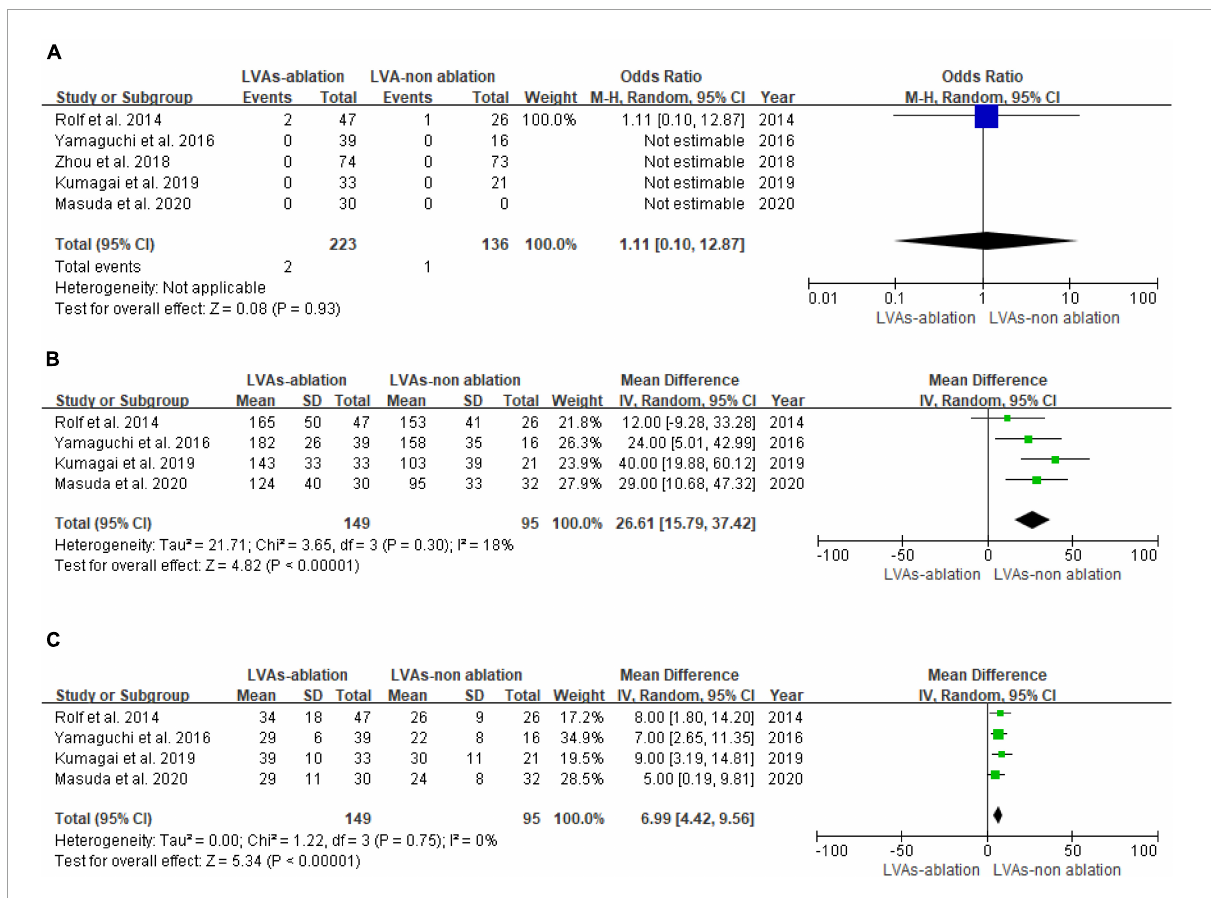
FIGURE4 Forest plot of procedural data. (A) Complication of LVAs patients with or without LVAs substrate modification. (B) Procedure time of LVAs patients with or without LVAs substrate modification. (C) Fluoroscopy time of LVAs patients with or without LVAs substrate modification.